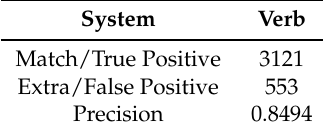
Table 13. System evaluation and performance over Data set